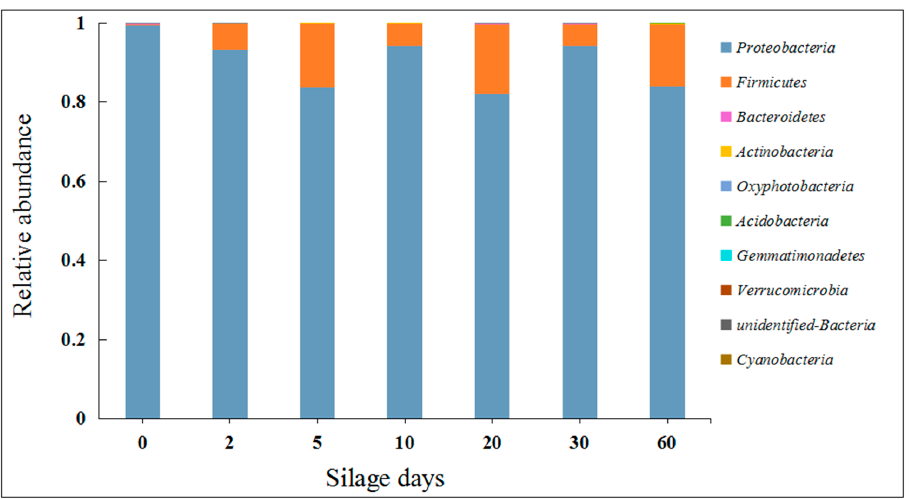
Figure 1. The relative abundances of bacterial communities at the phylum level in silage. The abscissa stands for silage time (on day 0, 2, 5, 10, 20, 30, and 60) and the ordinate stands for the relative abundance of each bacterial community at the phylum level.